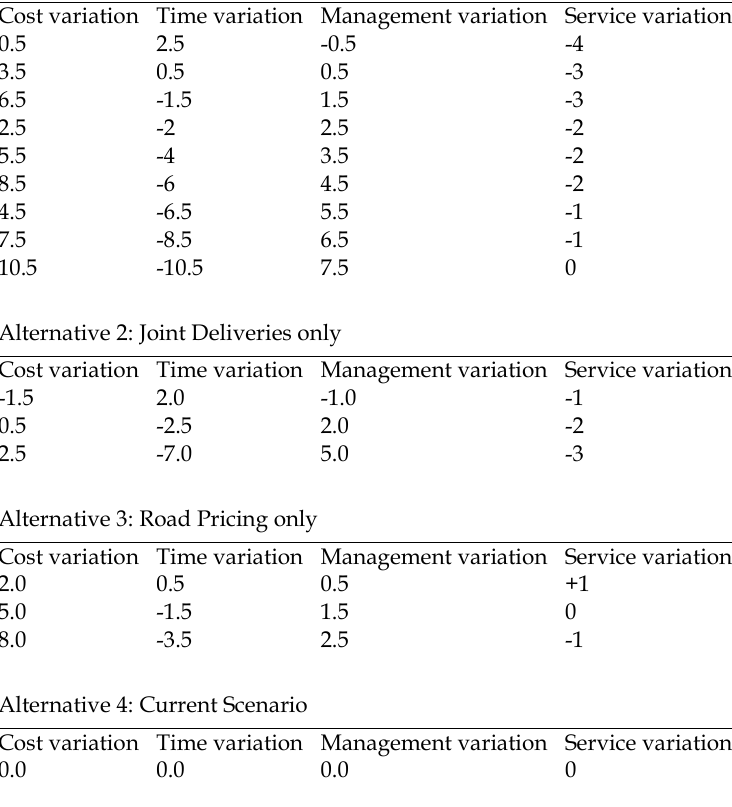
Table 7. Attribute levels for each alternative in the survey Alternative1: with Joint Deliveries and Road Pricing Cost variation Time variation Management variation Service